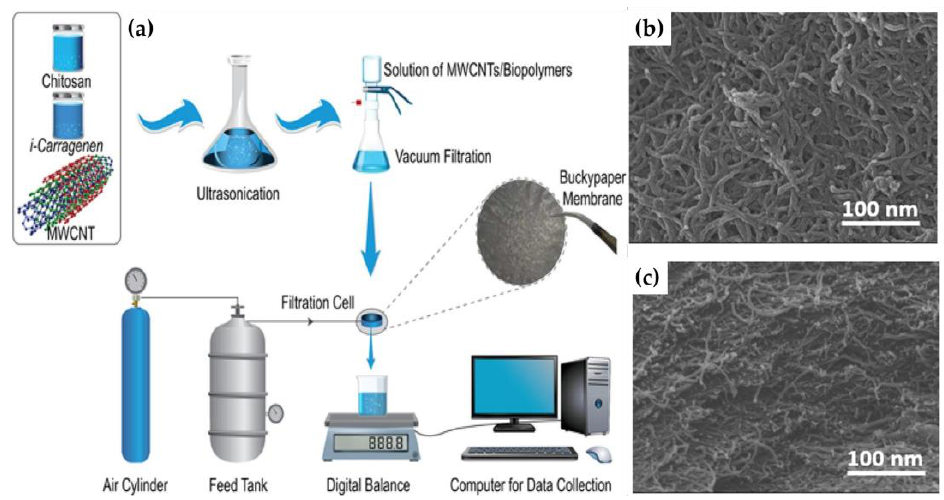
Figure 6. Schematic representation of the coating preparation and filtration test in the dead-end apparatus ( a ); SEM images of the MWCNTs/chitosan-carrageenan BP membrane surface ( b ) and cross-section ( c ). Reproduced with permission from Separation and Purification Technology; published by Elsevier, 2021 [84].